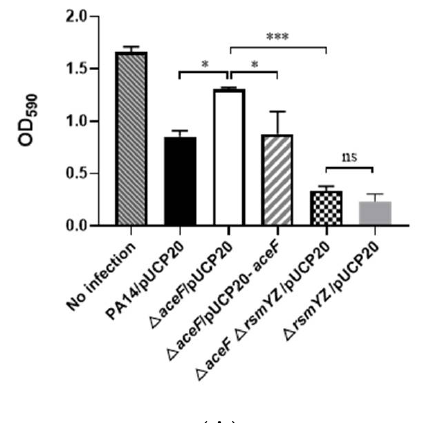
with or without 5 mM EGTA to an OD 600 of 1. The RNA levels of rsmY and rsmZ were determined by real-time PCR. ( B ) PA14, the Δ aceF mutant and the complemented strain containing the P rsmY - lacZ ( left ) and P rsmZ - lacZ ( right ) transcriptional fusion were cultured in LB with or without 5 mM EGTA to an OD 600 of 1, followed by determination of the β-galactosidase activity. Data shown represent